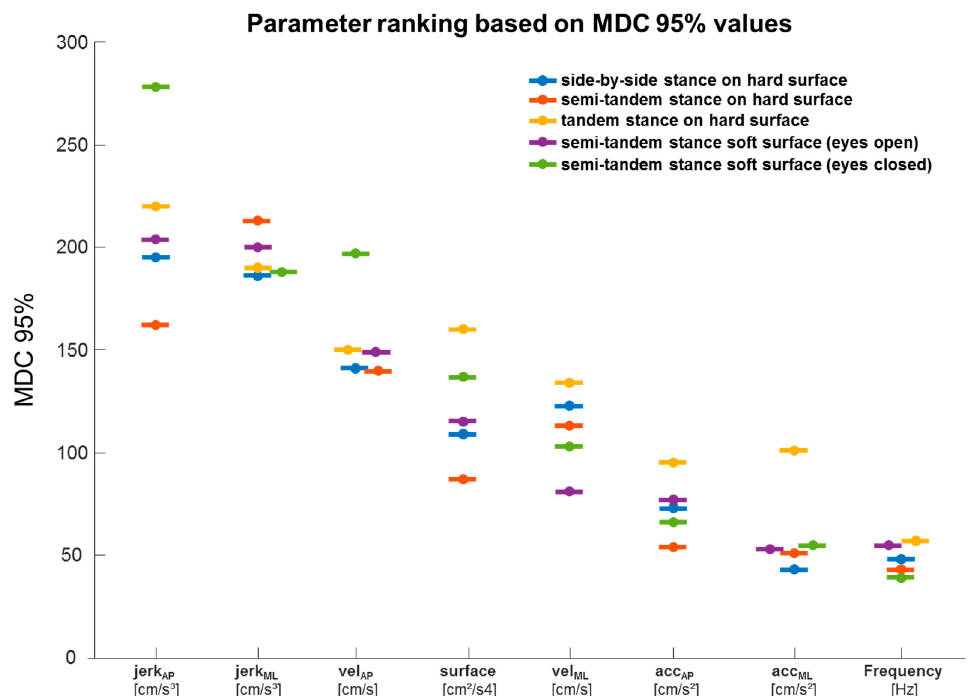
Figure 2. MDC95% values of all exercises and parameters ranked from high to low. X -axis = parameters, Y -axis = MDC95% values. Surface, vel AP = velocity in the AP direction, vel ML = velocity in the ML direction, acc AP = acceleration in the AP direction, acc ML = acceleration in the ML direction, jerk AP = jerk in the AP direction, jerk ML = jerk in the ML direction.